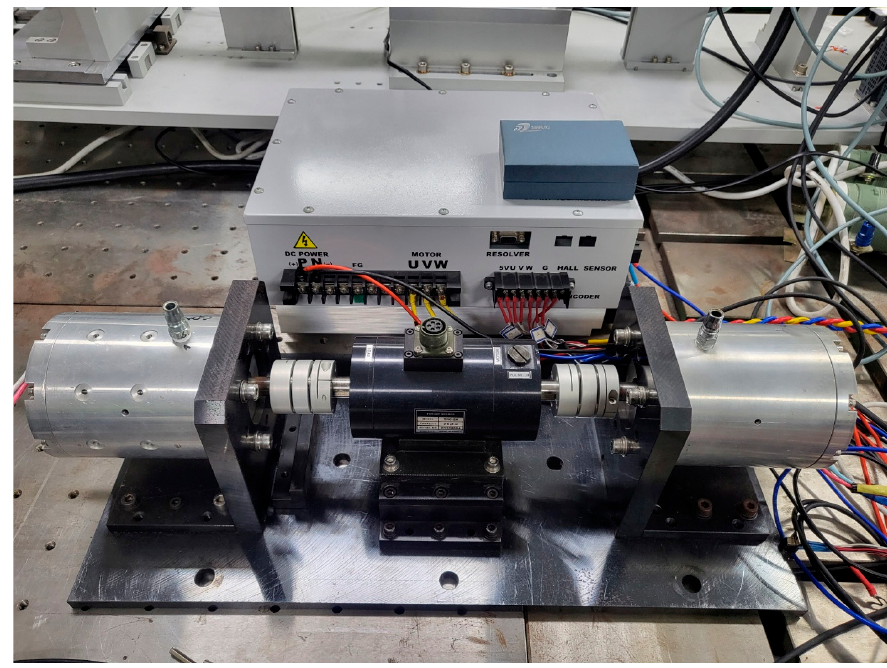
Figure 8. Experimental setup of the SPMSM and IPMSM .